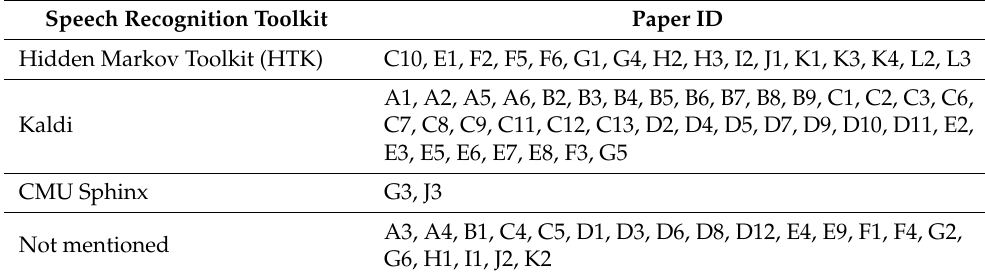
Table A2. SR Toolkits used in the studies.